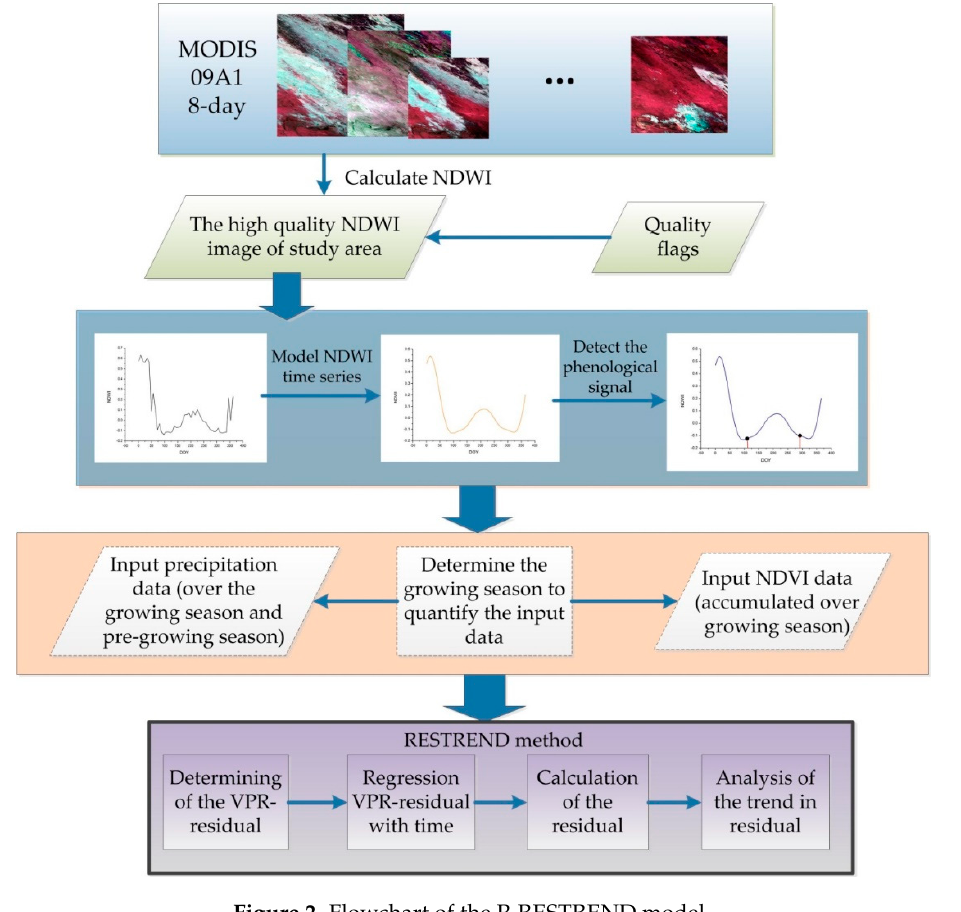
Figure 2. Flowchart of the P-RESTREND model.